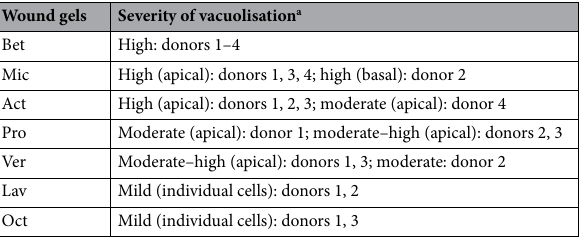
Table 2. Skin biopsies treated with different wound gels and severity of induced vacuolisation. a Most severe to least severe